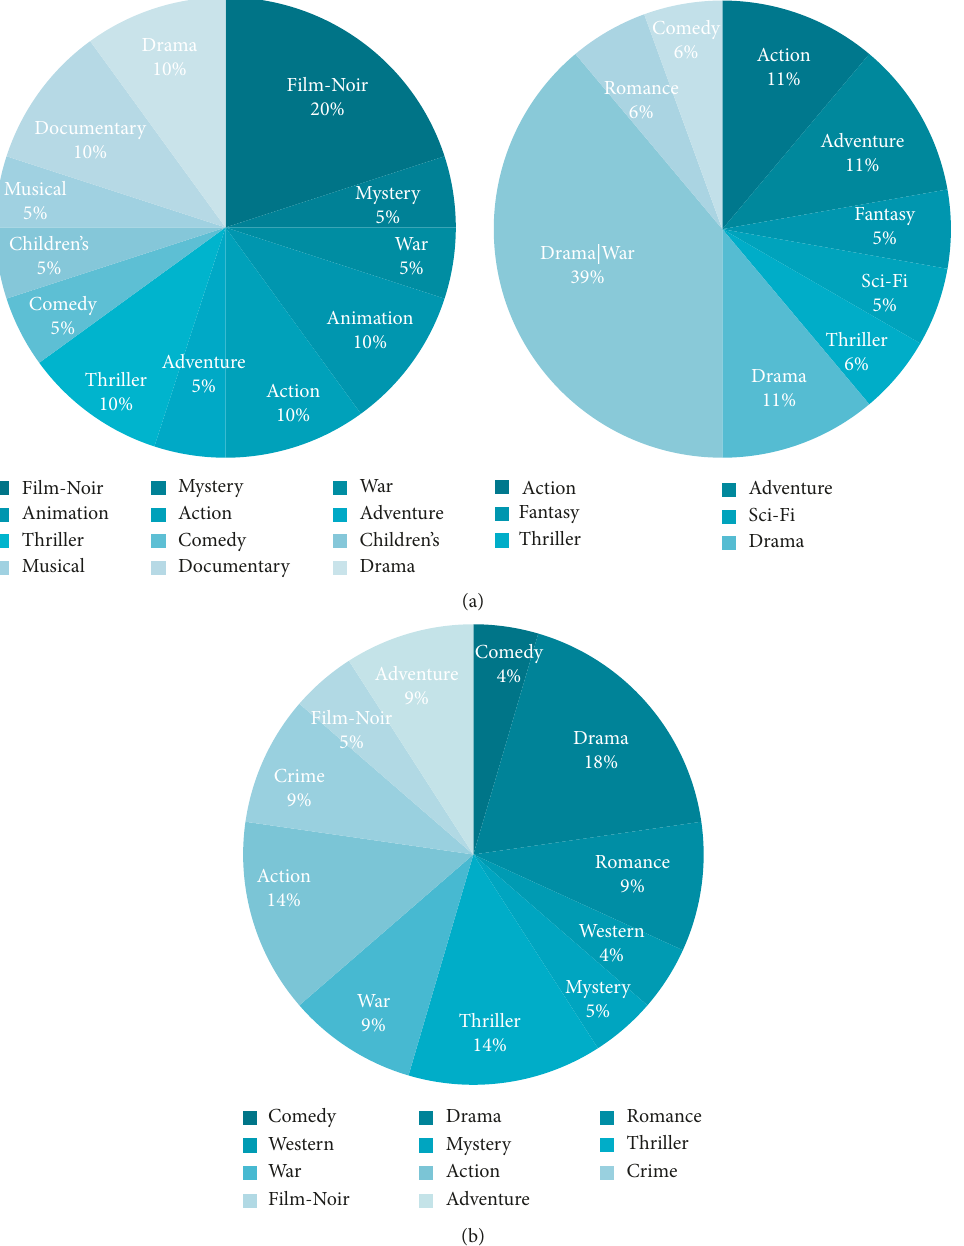
Figure 6: Recommended movie list with different algorithms. (a) The movie genres recommended by TC-PR. (b) The movie genres recommended by general CNN-based recommendation